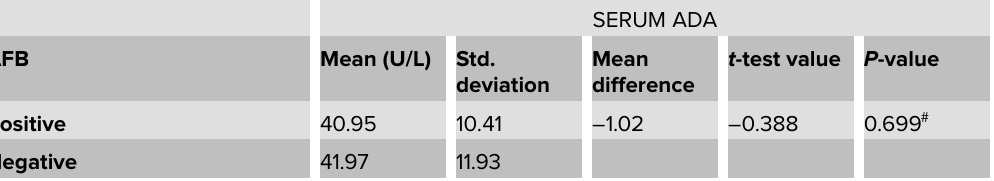
TABLE 2: Correlation of serum ADA levels with AFB status (demonstration on Ziehl-Neelsen-stained smear) in cases of tubercular lymphadenitis (Department of Pathology, TMU from January 2019 to June 2020) n = 154.